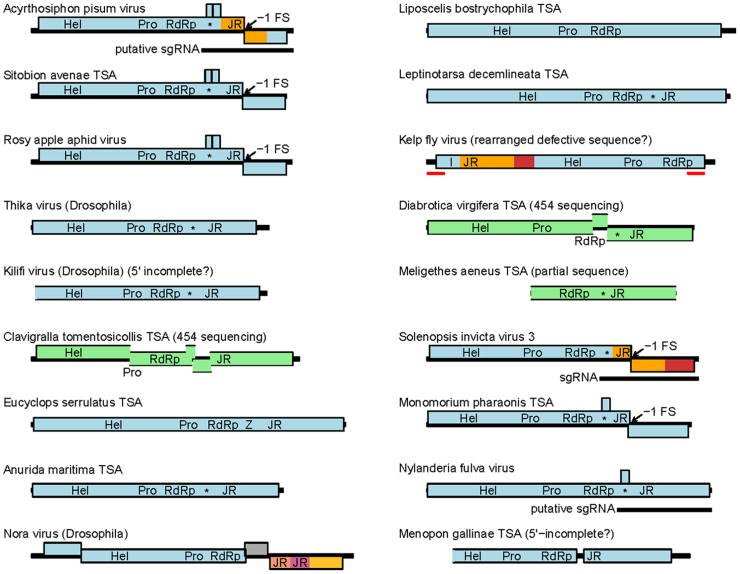
Genome maps of APV, SINV-3, NfV-1, related viruses, and TSA sequences likely to represent additional related viruses. Nora virus, the next most closely related virus (by RdRp-based phylogeny), is also shown for comparison. Sequences assembled from Roche 454 sequence data are shown in pale green with breaks in the polyprotein ORF presumed to have resulted from frame-shift sequencing errors indicated. (The Sitobion TSA also derives from 454 sequencing but high similarity to APV permitted unambiguous removal of three frame-shift errors.) Likely partial sequences are also indicated by un-closed rectangles, although it is possible that additional sequences are incomplete and therefore that some ORFs may be 5′-truncated. Red lines in KFV indicate a 638-nt sequence duplication that may indicate a rearranged defective sequence. Experimentally mapped capsid proteins for APV (van der Wilk et al., 1997), KFV (Hartley et al., 2005), Nora virus (Ekström et al., 2011), and SINV-3 (Valles et al., 2014a) are indicated in colors other than blue and green. Ribosomal −1 frameshift sites are indicated. Protein domains identified by conserved characteristic motifs (Hel – superfamily III helicase; Pro – 3C-like protease; RdRp – superfamily I RdRp) (Koonin et al., 2008) or HHpred (* – dsRNA binding domain; Z – zinc-finger domain; JR – picorna/calici-like jelly-roll capsid domain), as well as the baculoviral inhibitor of apoptosis repeat domain (I) in KFV identified by Hartley et al. (2005), are indicated. The SINV-3 sgRNA and corresponding putative sgRNAs for APV and NfV-1 are indicated; however we expect that all these viruses produce a similarly located sgRNA for capsid protein expression.